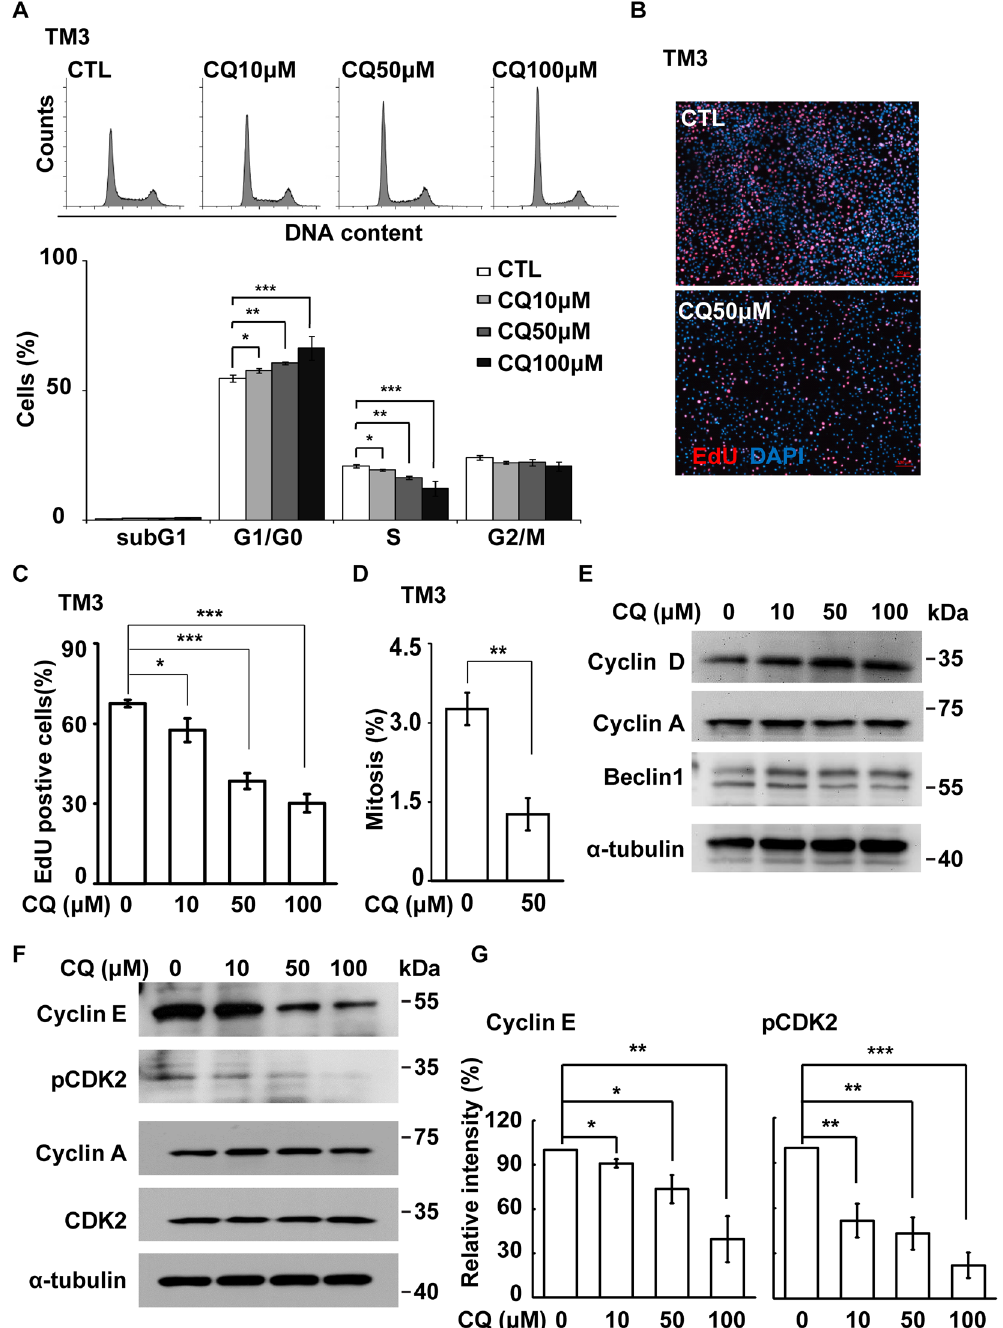
Figure 3. Inhibition of lysosomes leads to G1 arrest by inactivating cyclin E/CDK2 complex. ( A ) CQ treatment (10, 50, or 100 μ M, 24 h) leads to cell cycle G1 arrest. Quantitation of different cell cycle stages in TM3 cells in the presence or absence of CQ. ( B – D ) EdU incorporation and mitotic index are reduced in CQ-treated TM3 cells. ( B ) Immunostaining of EdU (red) and DAPI (blue) in scramble control (CTL) or CQ treated TM3 cells. Quantitation of EdU incorporation ( C ) or mitotic index ( D ) in scramble control (CTL) or CQ-treated TM3 cells. These results are mean + / − SD from three independent experiments; more than 1000 cells were counted in each individual group. ( E – G ) CQ inhibited cyclin E1 expression and CDK2 activation. ( E , F ) Whole cell extracts of CQ-treated TM3 cells at the concentration of 10, 50, or 100 μ M are analyzed by immunoblot with antibodies against Beclin1, cyclin D, cyclin A, cyclin E1, CDK2, phosphorylated CDK2 at Thr160 (pCDK2) and α -tubulin. ( G ) Quantitation of relative intensity of cyclin E and pCDK2 in ( F ). * P < 0.05; ** P < 0.01; *** P <